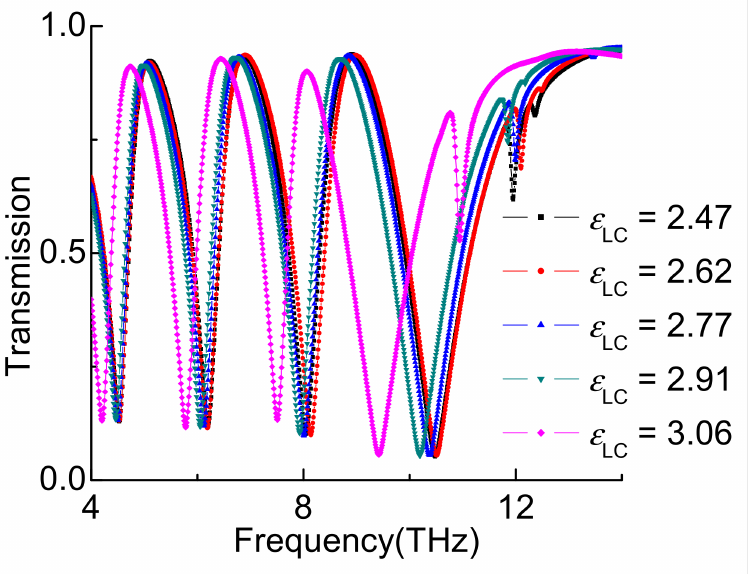
Figure 4. Transmission spectrum with different ε LC .